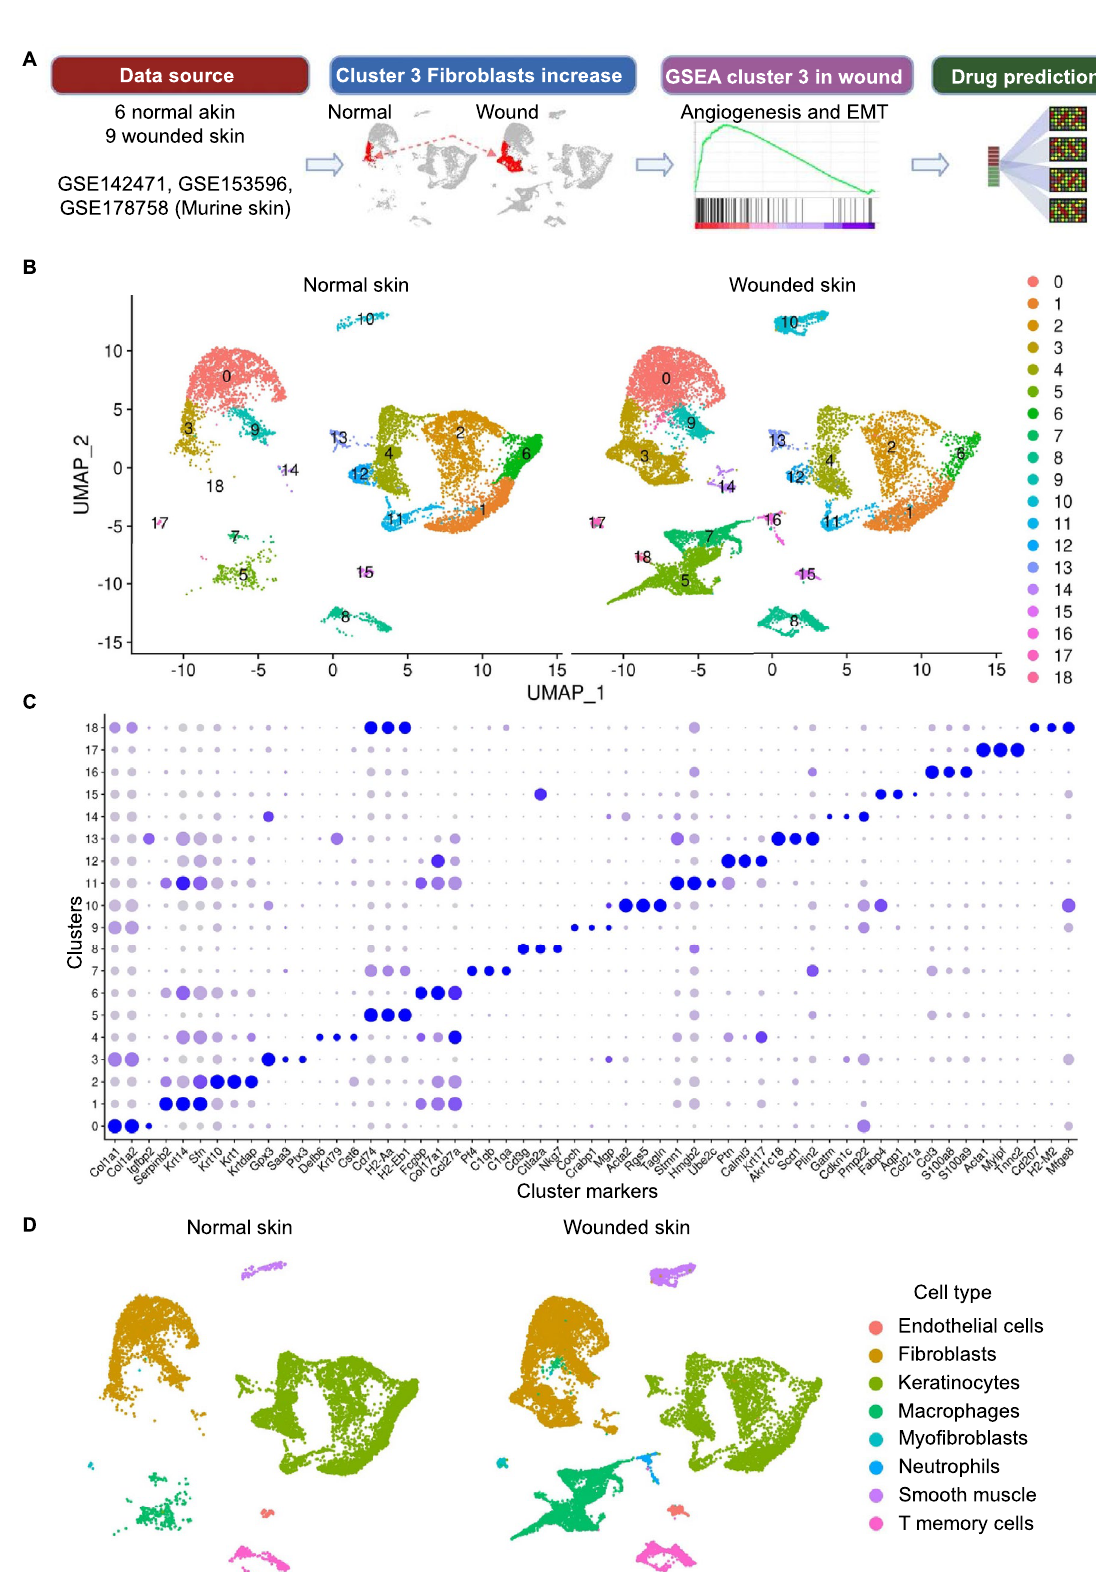
Figure 1. Identification of 19 distinct clusters. ( A ) The analysis overview. ( B ) UMAP plot showing 19 distinct clusters. Each dot represents a single cell. Left panel represents normal skin cells and right panel represents wounded skin at day 4 post wounding (GSE14271). ( C ) Dotplot representing the top 3 markers in each cluster. (D) UMAP plots showing eight cell types for each condition (normal skin and wounded